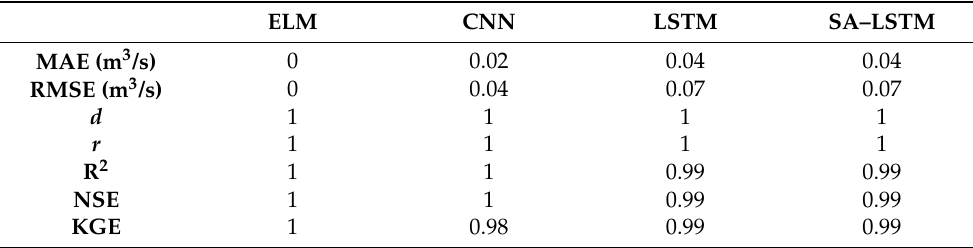
Table 2. Summary of model evaluation metrics during the training